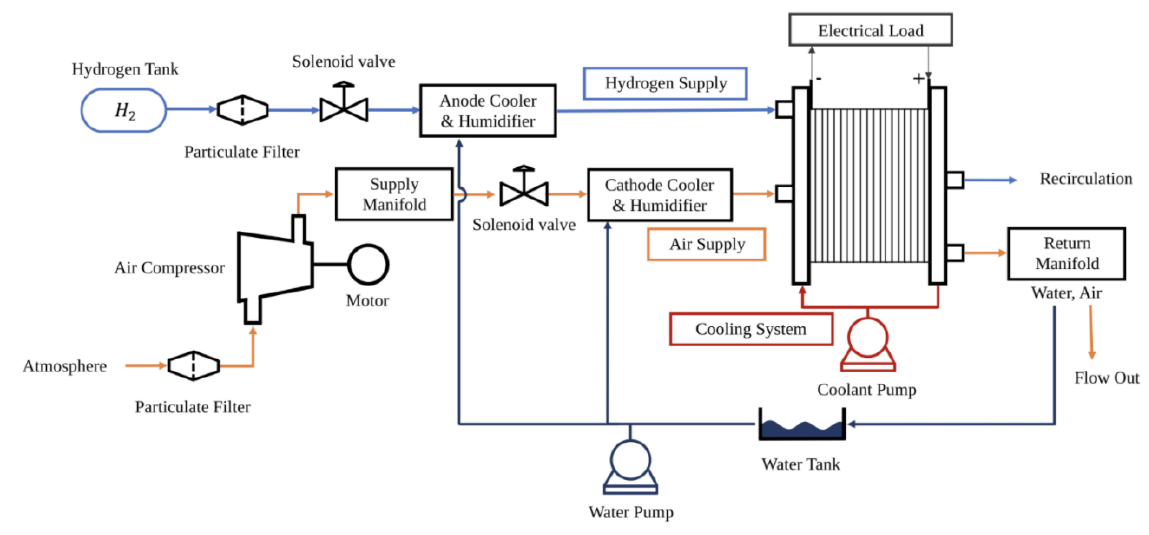
Figure 1. PEM fuel cell